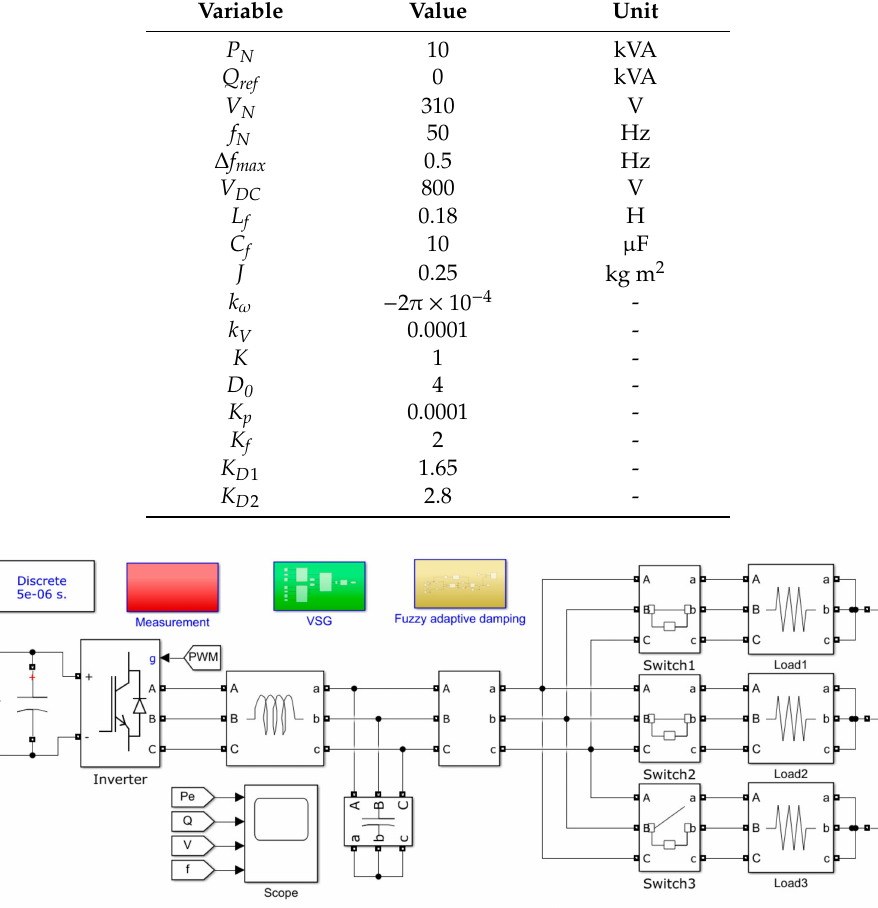
Table 2. Main parameters of the microgrid.